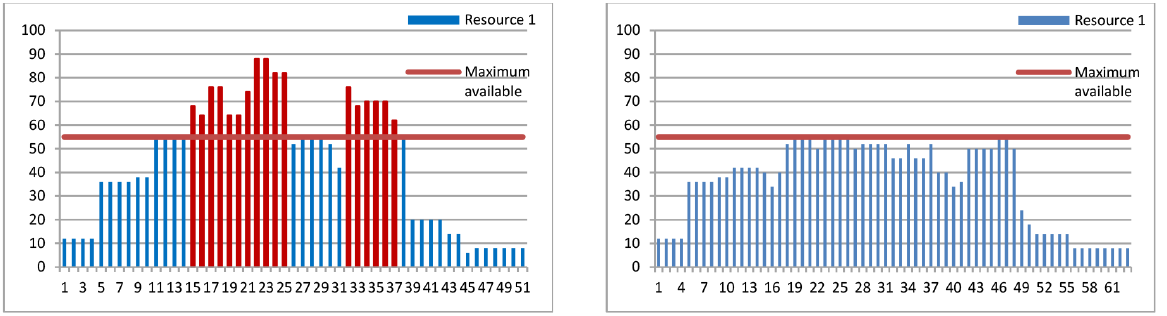
Figure 47. Daily usage of resource 1 throughout the calendar of the project (before using the method)-Experiment